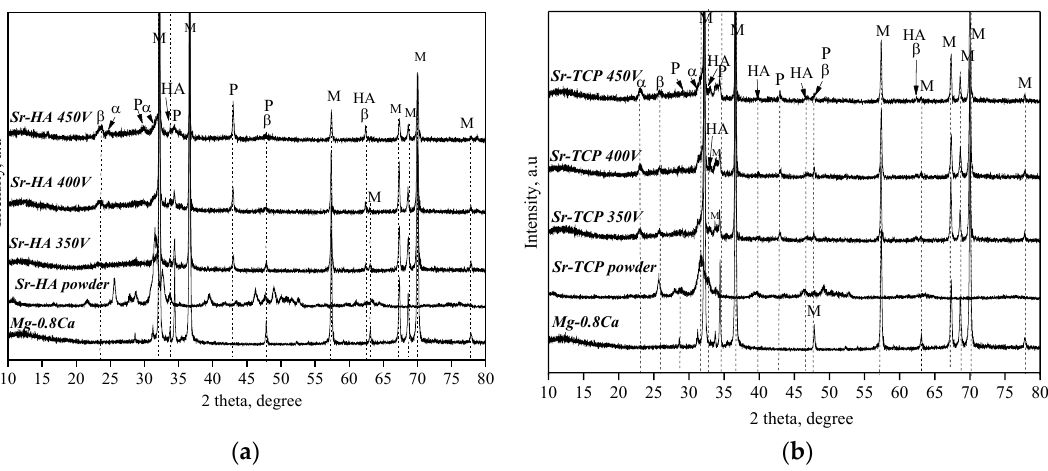
Figure 4. X-ray powder diffraction (XRD) patterns of the Sr-HA ( a ) and Sr-TCP, ( b ) coatings deposited on Mg0.8Ca under different voltages; β—β-Ca 3 (PO 4 ) 2 , α—α-Ca 3 (PO 4 ) 2 , HA—Ca 10 (PO 4 ) 6 (OH) 2 , P—Mg 3 (PO 4 ) 2 , and M—magnesium.